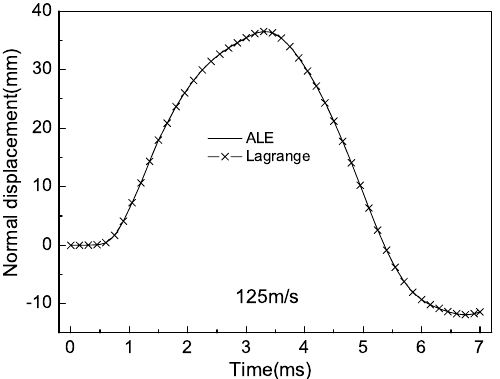
Fig. 20. Time history of normal displacement at the center on inner surface of windshield for different analytic